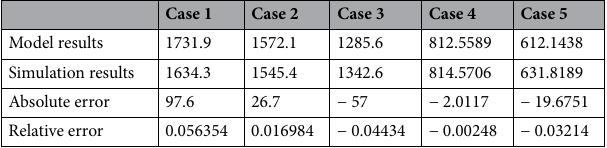
Table 5. Model results and simulation results of the return routing strategy.